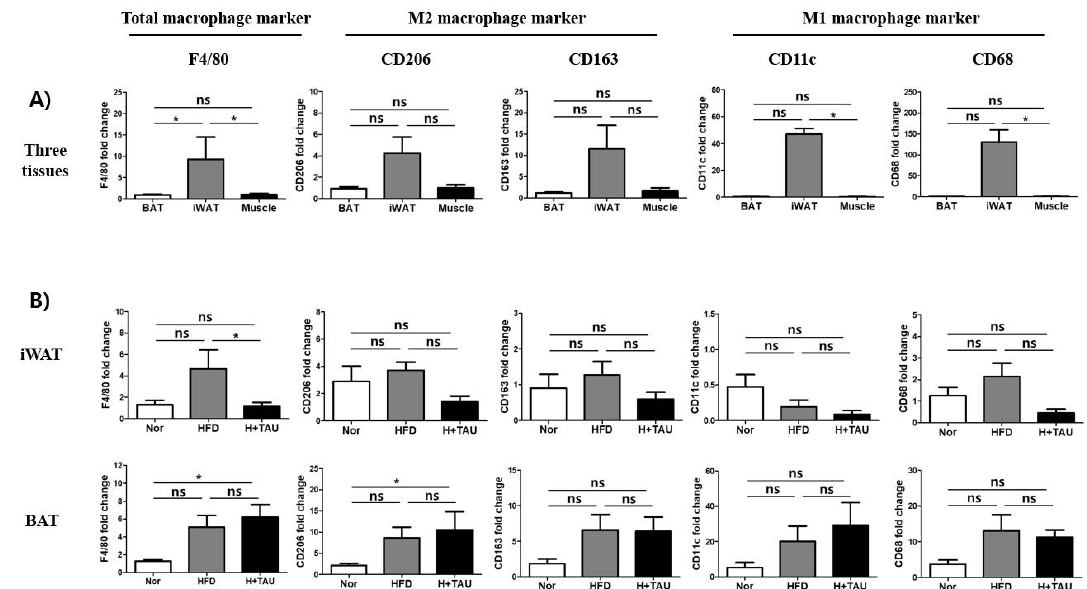
Figure 5. E ff ect of taurine on the shift from M1 to M2 macrophages in fat tissues. ( A ) The relative basal mRNA expression levels of the macrophage marker genes (F4 / 80) and M1 (CD11c and CD68) and M2 (CD206 and CD163) macrophage-specific marker genes were investigated to determine how many M1 and M2 macrophages existed in iWAT and BAT of the normal diet (N) group. ( B ) The e ff ect of HFD or taurine supplementation on the mRNA expression levels was investigated to determine if HFD or taurine supplementation a ff ected the infiltration of macrophages into fat tissues and the shift of M1 / M2 macrophages in iWAT and BAT: N normal diet group ( n = 5), HFD high-fat diet group ( n = 5), and H + Tau HFD + taurine (2% in drinking water) group ( n = 5). Di ff erences between the three groups were analyzed using the nonparametric Kruskal–Wallis test as described in Figure 2. Di ff erences were considered statistically significant at p < 0.05. * p < 0.05; ns not